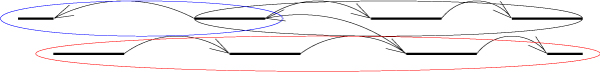
Scaffold construction. A chain of contigs in the same direction is used as a scaffold. Three different scaffold are shown in this figure in red, blue and black.